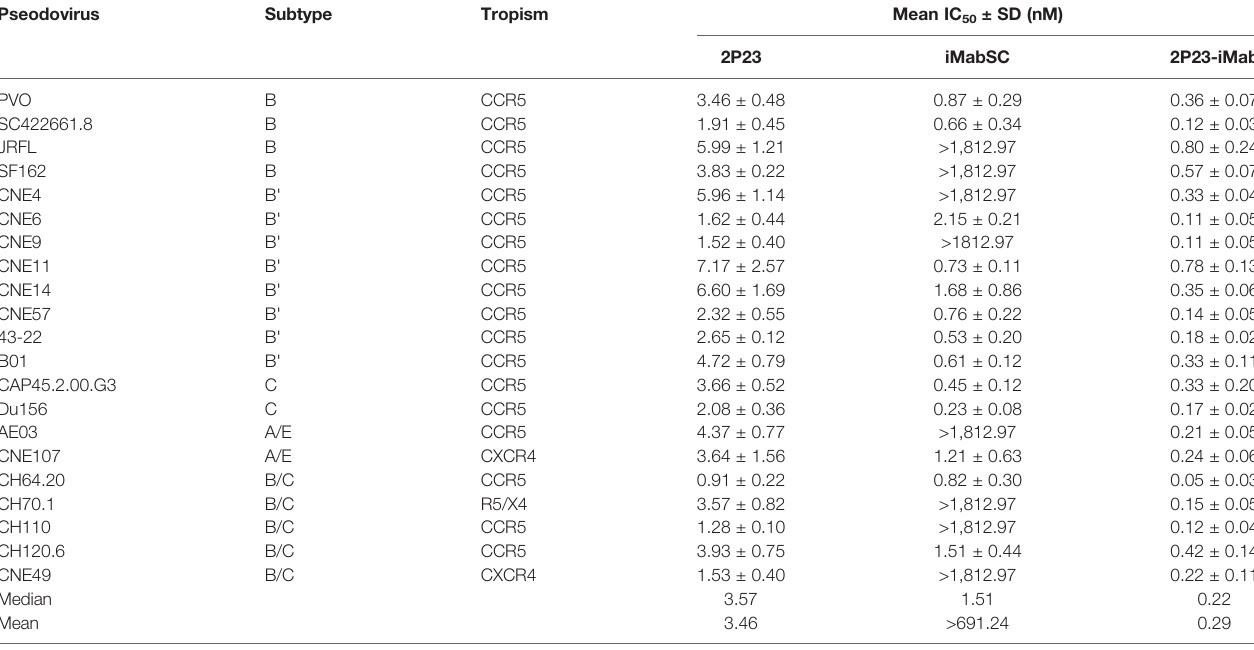
The experiments were performed in triplicate and repeated three times. Data are expressed as means ±